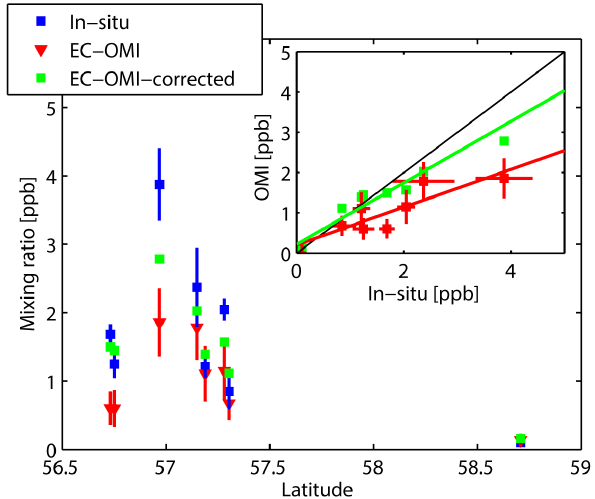
Fig. 12. Average (2005–2011) ground-based in situ and EC-vmr- derived SO 2 surface mixing ratio measurements as a function of WBEA station latitude. Inset is the scatter plot comparing ground- based measurements with the EC-vmr’s. The red represents original OMI-vmr’s, while the green is after accounting for smoothing and clear-sky bias. Errors bars denote twice the standard error of the mean. The lines in the inset represent the linear